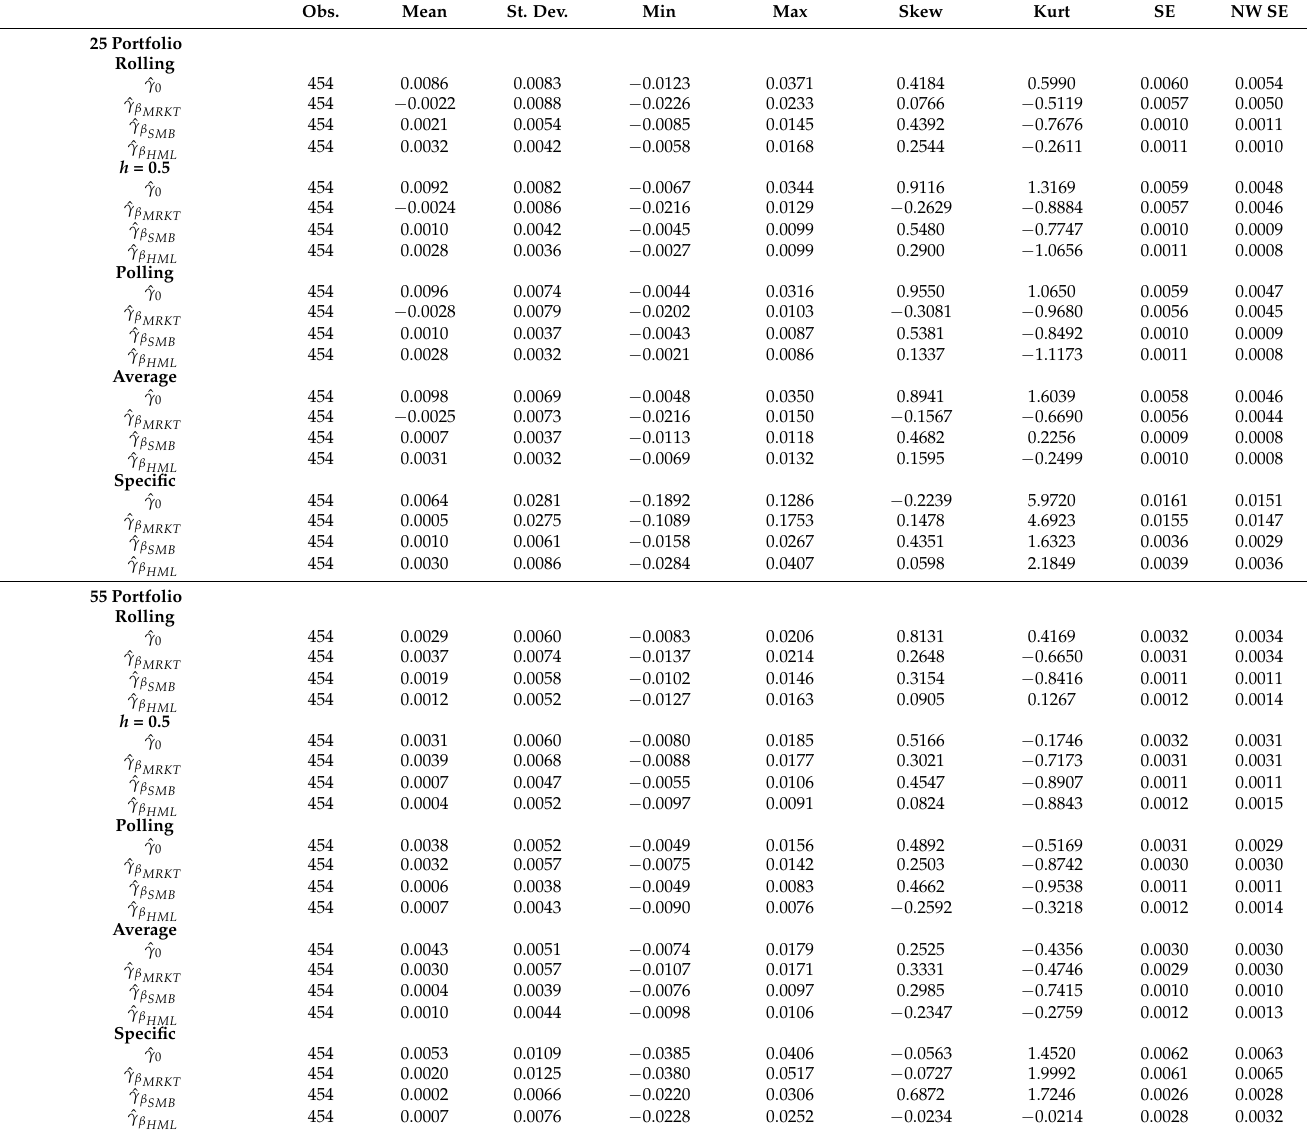
Table 4. Descriptive statistics of risk premium